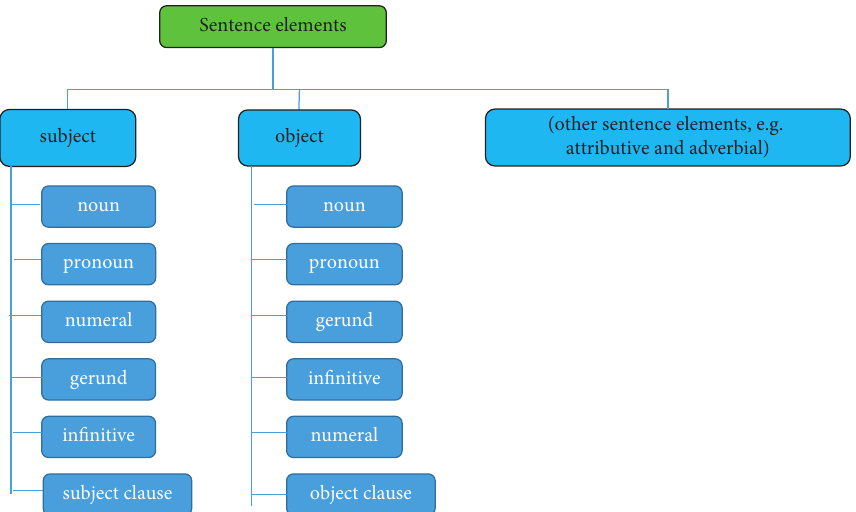
Figure 1: A schematic presenting sentence elements based on their syntagmatic relations and paradigmatic